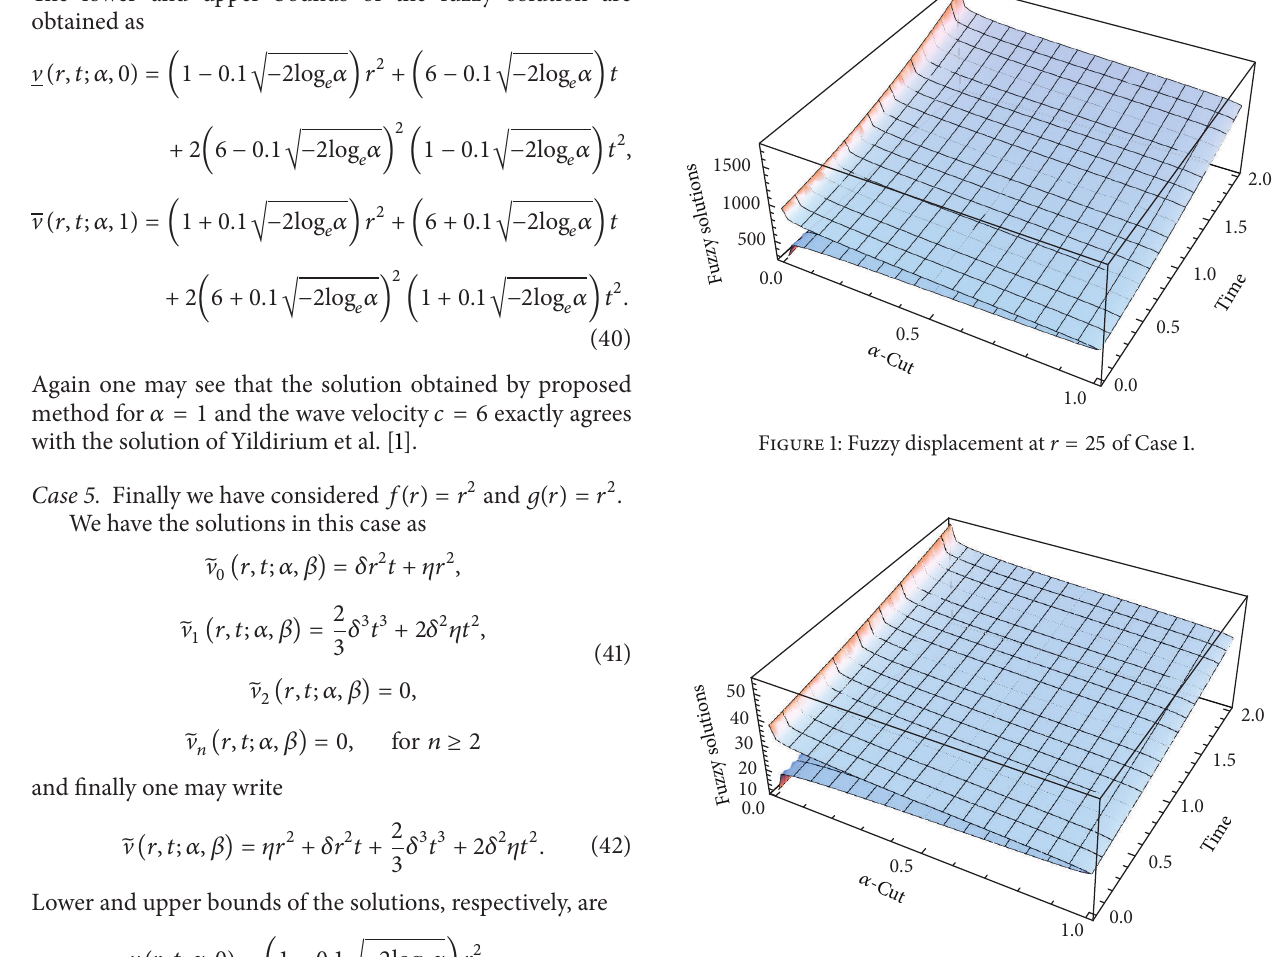
Figure 2: Fuzzy solution at 𝑟 = 25 of Case